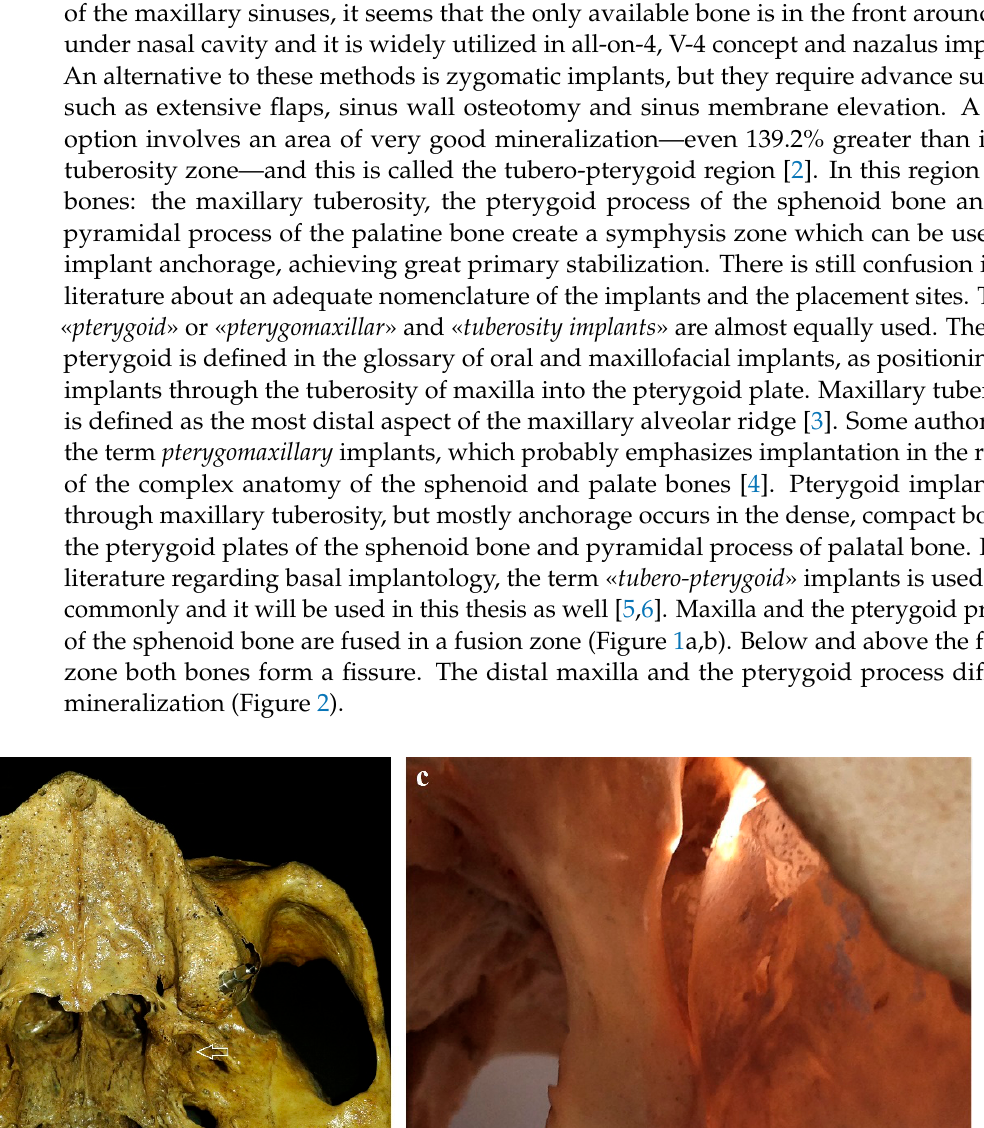
Figure 2. View on distal maxilla and adjacent processus pterygoideus of the sphenoid bone on a panoramic picture. Both the bone of the pterygoid processus pterygoideus and the anterior maxilla show high mineralization, whereas the bone in the region of the two premolars appears strongly atrophied (both from the side of the maxillary sinus and from the crest of the alveolar process) and with low mineralization.